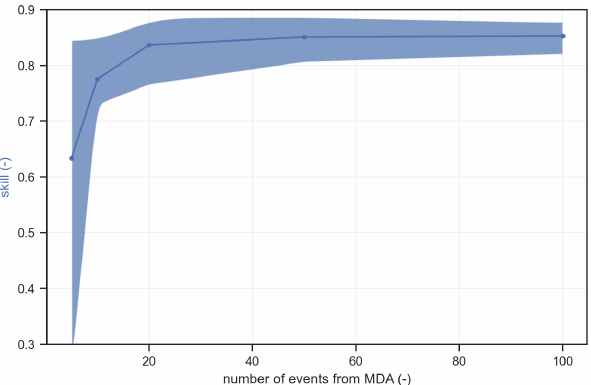
Figure 12. Skill value for a different number of training storm events used from the MDA (5, 10, 20, 50 and 100). The thick line shows the mean values while the patch indicates the min and max values between the 10 randomizations of the validation dataset. The patch extents have been smoothed using a Gaussian